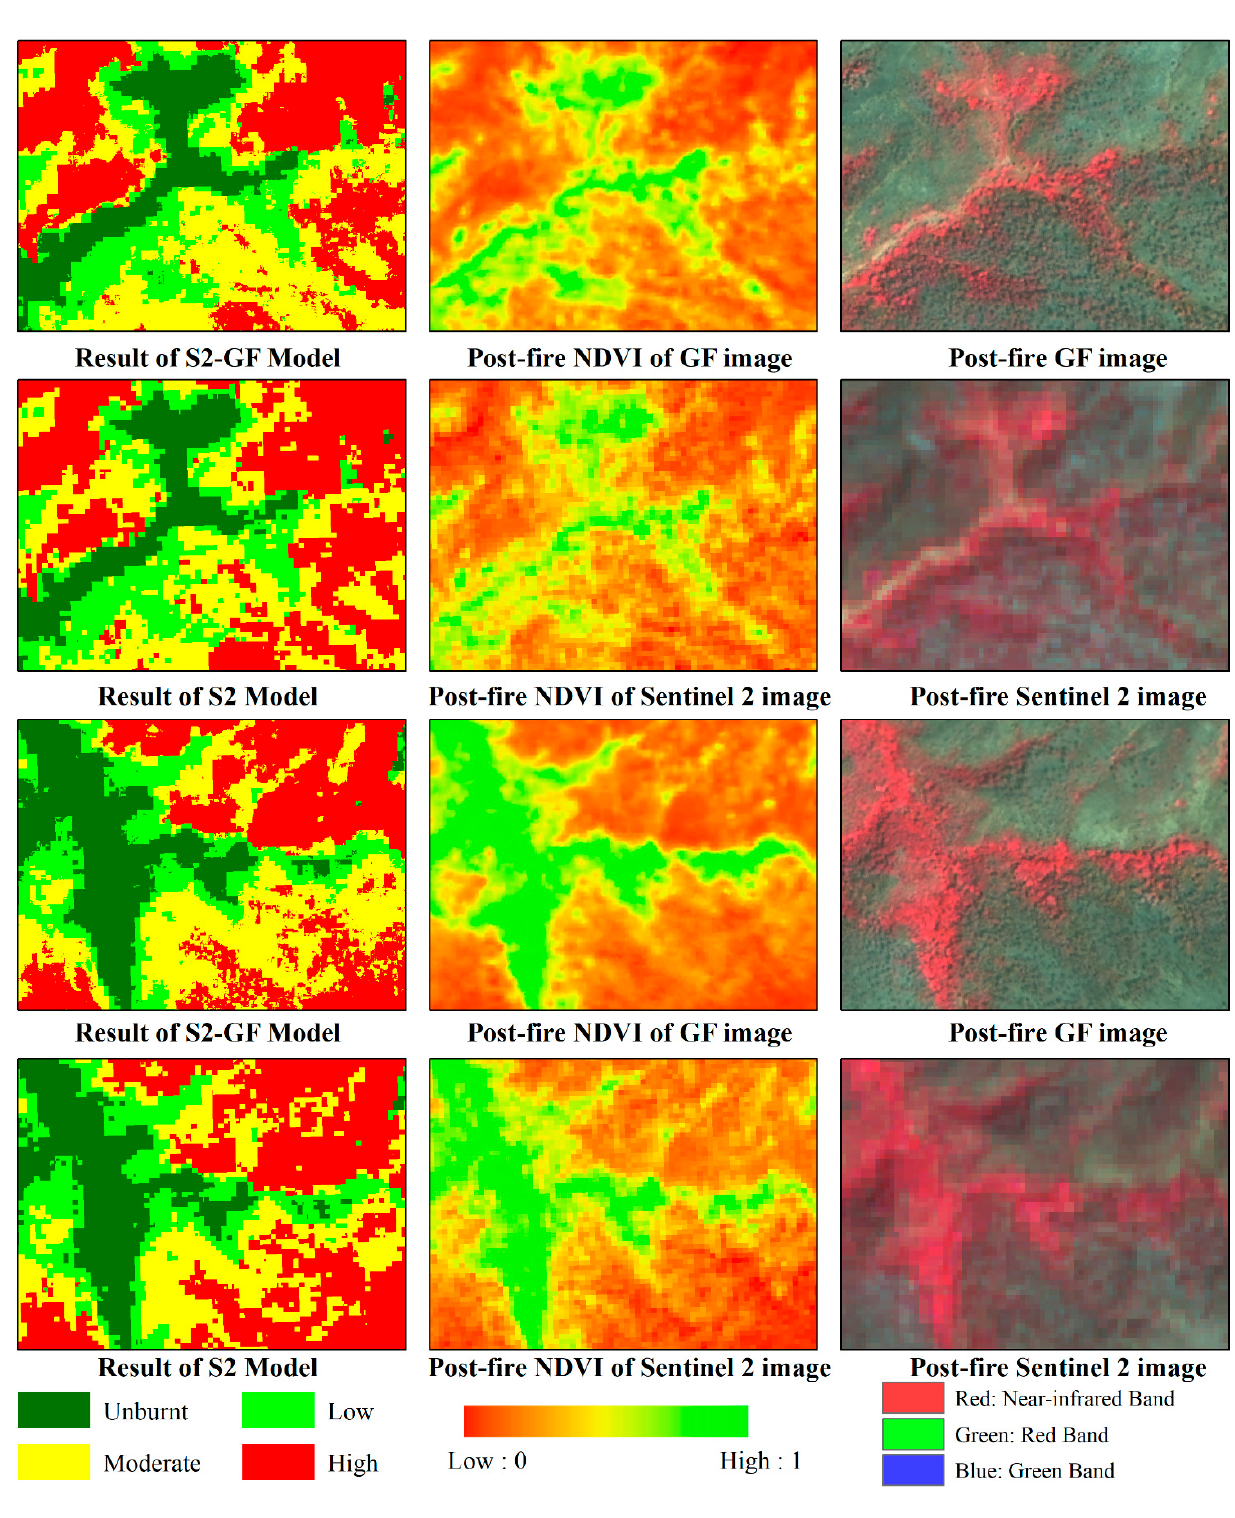
Figure 9. Comparison between the prediction results, post-NDVI features, and images of the two models. Due to the higher resolution, there were fewer mixed pixels in the GF image than in the Sentinel 2 image, especially in the transitional areas where the fire severity changes from low to high. The post-fire NDVI of GF images provided vegetation information with higher resolution, which can significantly improve the accuracy of fire severity classes in areas with highly variable fire severity classes.